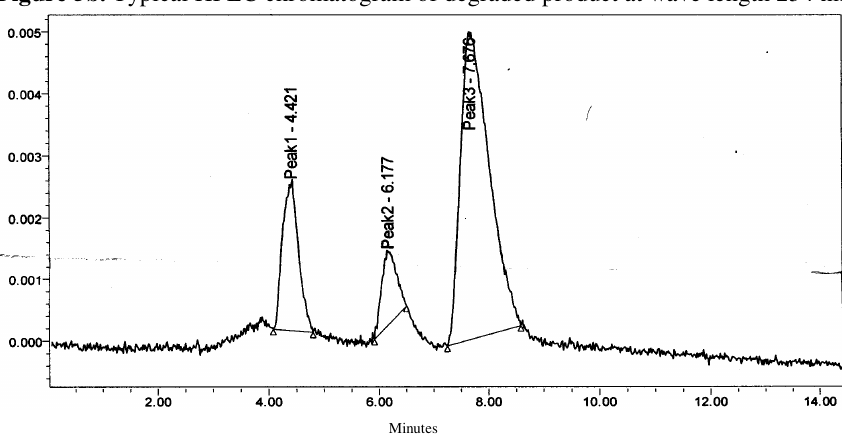
Figure 5c. Typical HPLC chromatogram of degraded product at wave length 344 nm